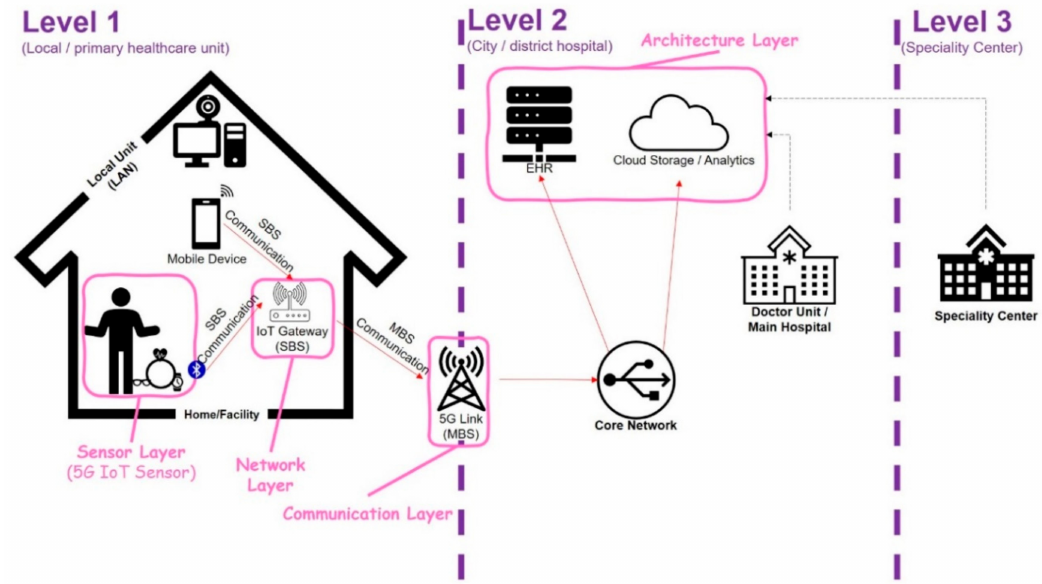
Figure 1. A general telemedicine system with asynchronous telemedicine and synchronous telemedicine